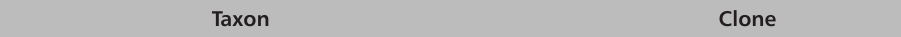
tABLE 1. Tested willow clones for biomass production in short rotation forestry